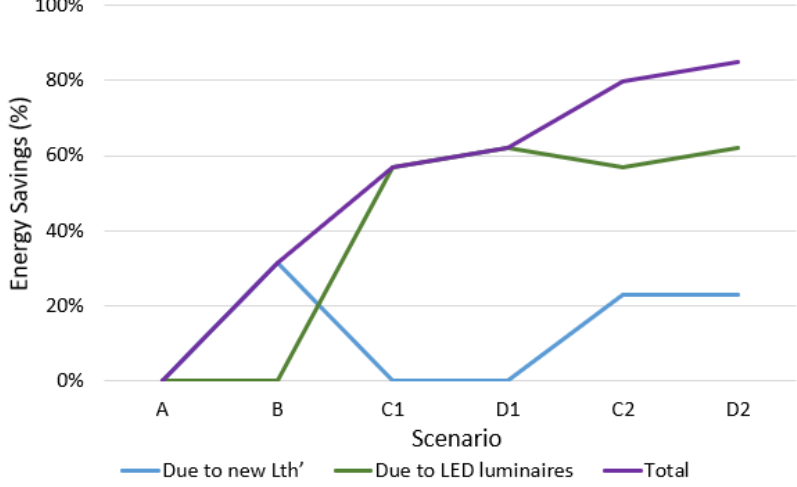
Figure 8. Breakdown of the energy savings due to the new calculated Lth’ values and the retrofit of the existing luminaires with new LED luminaires for each of the examined scenarios.